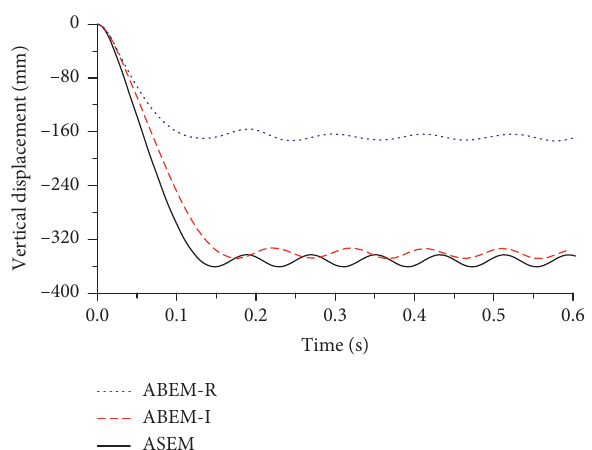
Figure 16: Vertical displacement-time histories of the failure